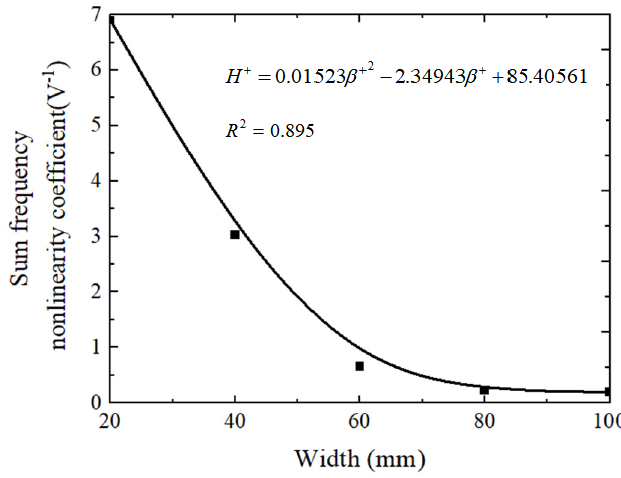
Figure 18. Variation of sum frequency factor with crack width.